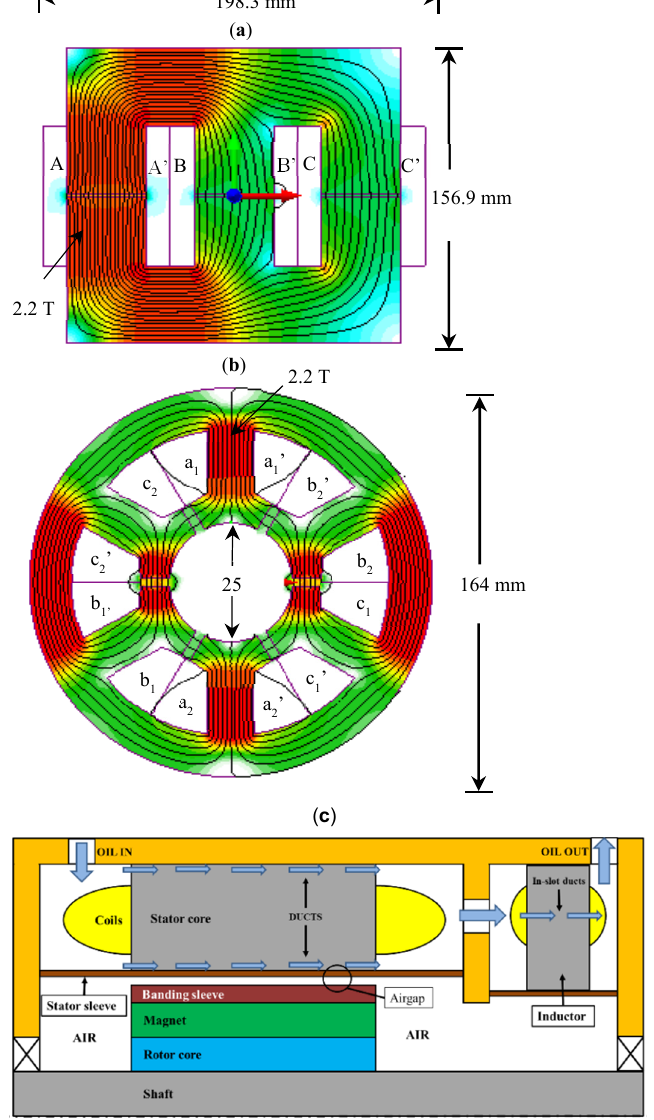
Figure 13. Radial Cross-section and Flux Map ( a ) EE-core Inductor ( b ) Integrated Rotor-less Inductor ( c ) Direct cooling model of aF combined system (Machine + Inductor). Table 4. Size and Loss Comparison (at room temperature) of EE-core and Integrated Rotor-less Inductor with Starter-Generator (SG).